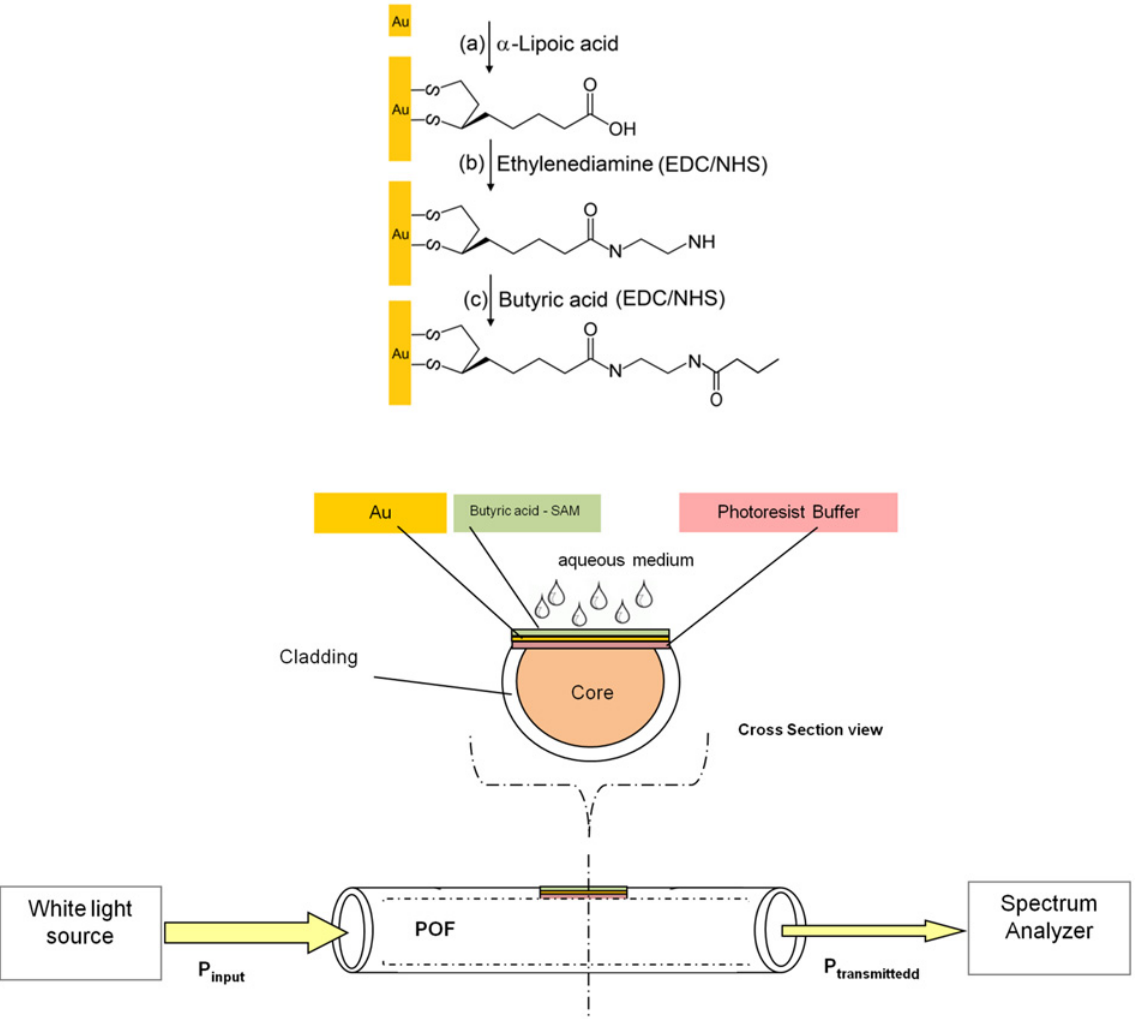
Fig 1. Optical biosensor based on SPR in a POF and experimental setup. Scheme of synthesis of derivatized SAM on chip POF. The gold surface was treated sequentially with a solution of α -lipoic acid (a), ethylenediamine (b) and butyric acid